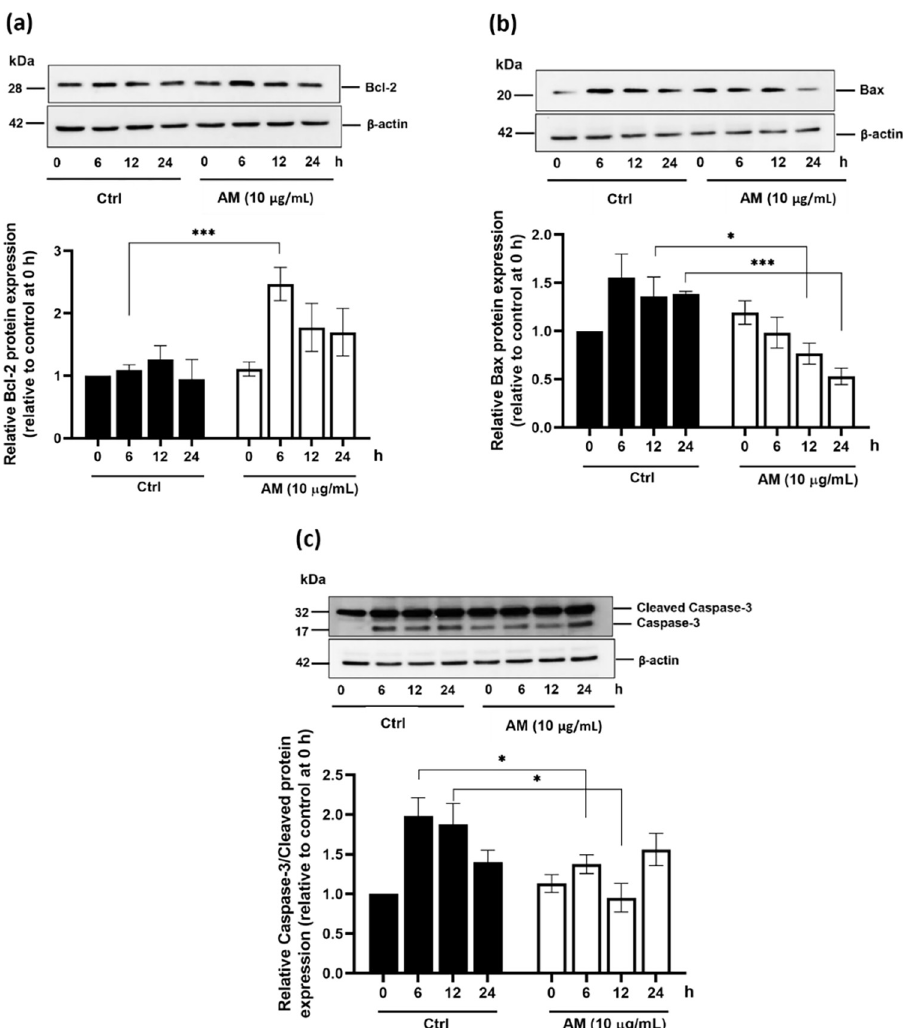
Fig 8. The effect of the AM extract on the protein expression of anti-apoptotic mediators. DPCs were incubated with T (30 μ M) as a control, and were treated with the AM extract (10 μ g/mL) for various periods (6, 12, and 24 h). The bar graph data analysis of the undertaken Western blotting is presented relatively to the control group at 0 h. The expression levels of Bcl-2 (a), Bax (b), and cleaved caspase-3 (c) are presented. All data are presented as mean ± SD (n = 3). * p < 0.05, and *** p < 0.005 versus non-treated